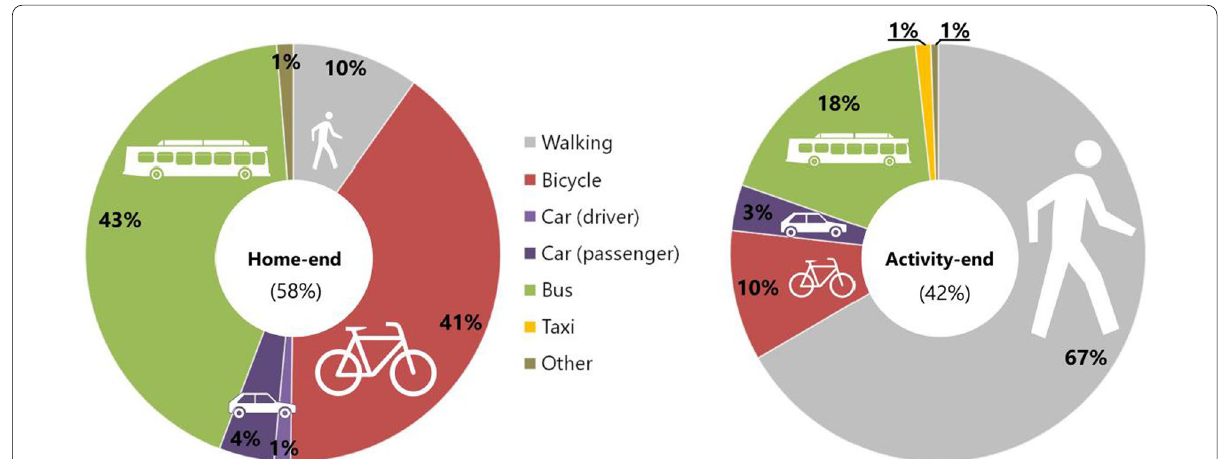
Fig. 4 Modal split of Almere Centrum for home‑end trips and activity‑end trips